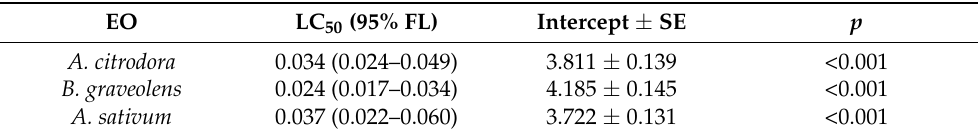
Table 2. Toxicity of Aloysia citrodora, Bursera graveolens , and Allium sativum essential oils (EOs) to eggs of the blowfly Calliphora vomitoria .